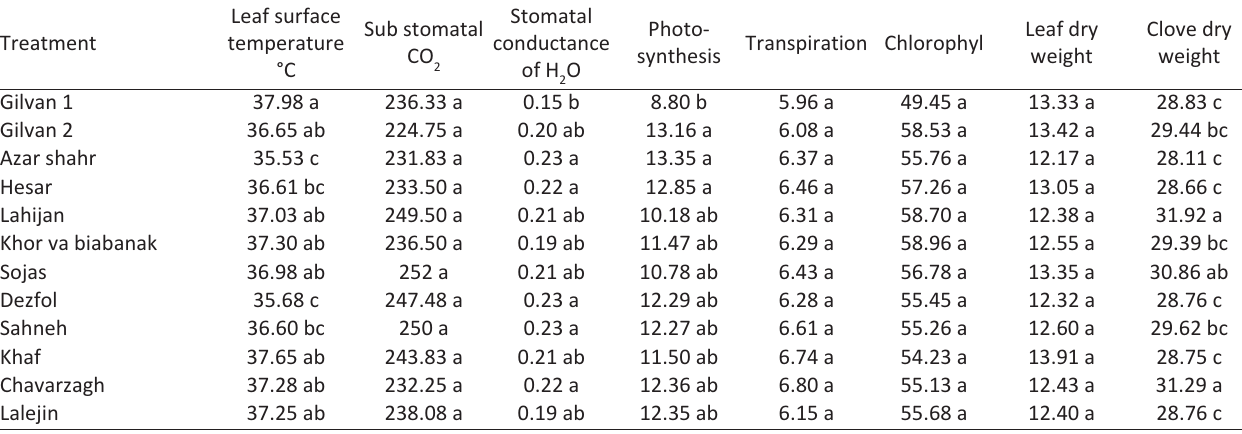
Table 7 ­ Mean comparison of physiological traits in some Iranian garlic at two years